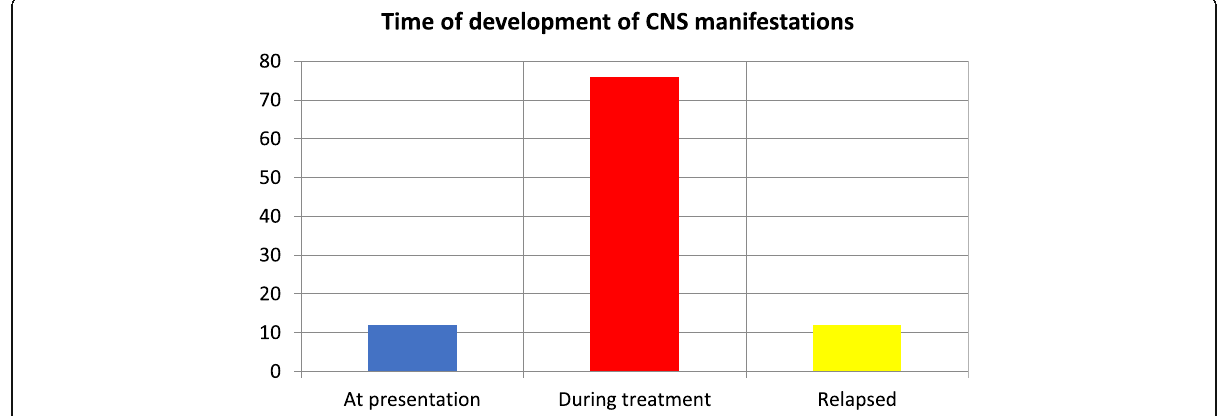
Fig. 2 Time of development of CNS manifestations among the studied